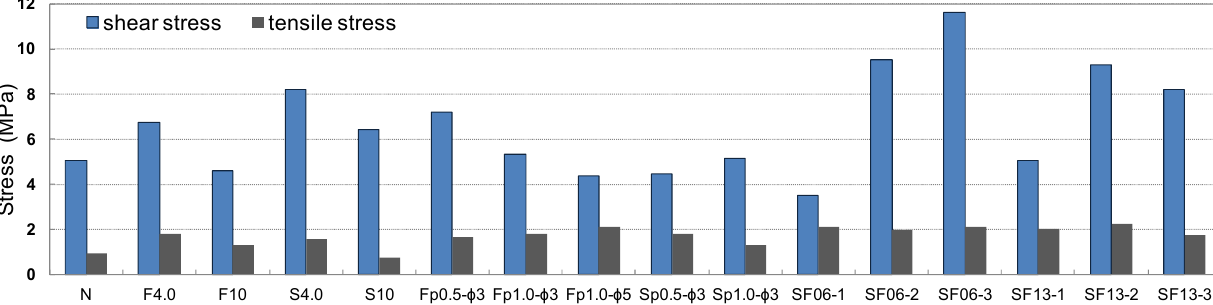
Figure 17. Shear and tensile bond strengths of cementitious joint using a conductive resistor.